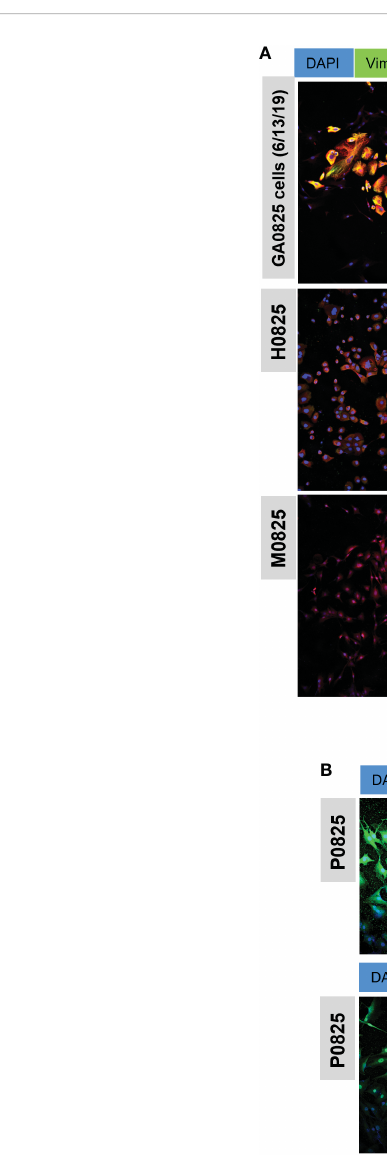
FIGURE 7 Immuno fl uorescence (IF) staining of cancer markers KRT19 (CK19) and EpCam, oncogene Yap1, stem cell marker Sox9, EMT marker Vimentin, and fi broblast marker FAP. (A) IF staining in human/mouse mixed pool GA0825 cells (6/13/2019) derived from GA0825-PDX-G1 (Figure 4E), human H0825 cells and murine M0825 cells. (B) mCherry labeled murine P0825 was stained with the same markers as in (A) , but second antibodies GFP 488 -conjugated Alex Fluor were used for green